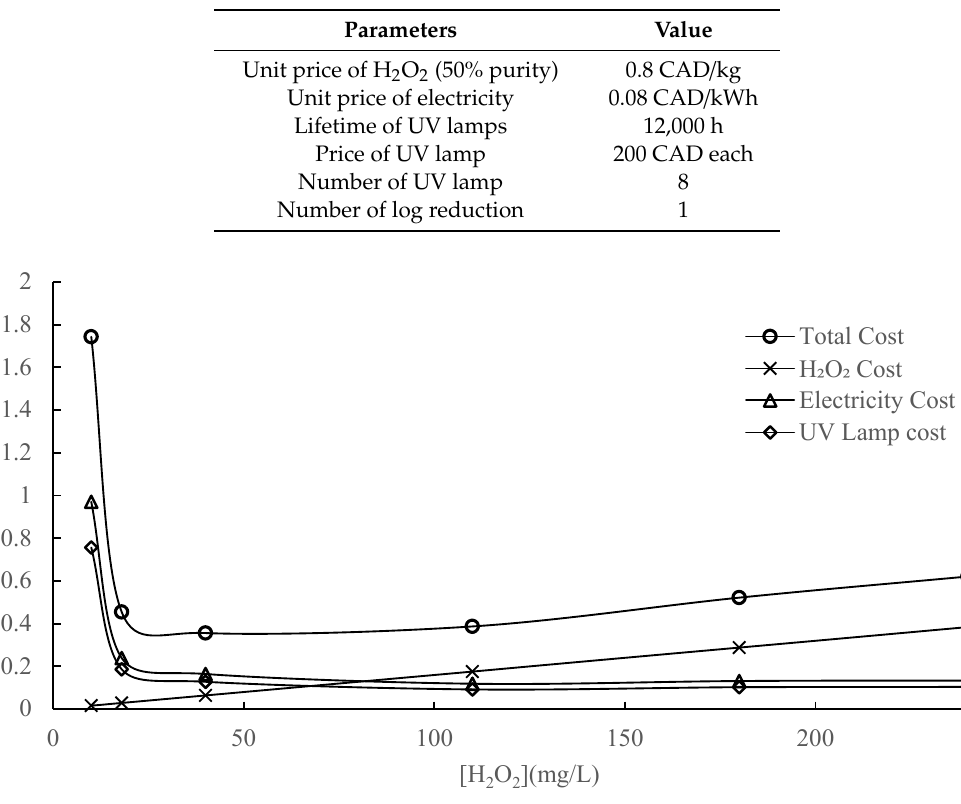
Figure 7. H 2 O 2 cost, electricity energy cost, UV lamp cost, and total cost versus [H 2 O 2 ]: Water II, [sulfolane] = 9.5 mg/L.